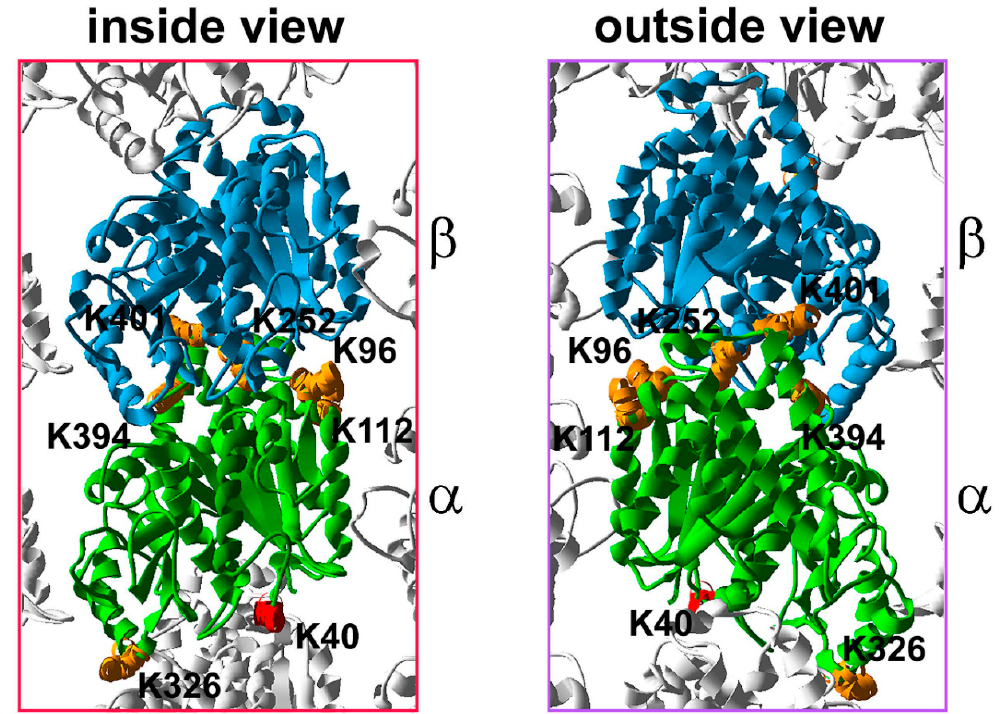
Figure 2. The distribution of the acetylated residues within the α , β -tubulin heterodimer. 3D model of a tubulin heterodimer within the microtubule lattice based on 3J6F.pdb (NCBI database), an inside and outside view. Putative acetylation sites are marked in orange. An approximate location of K40 is marked in red (K40 was not included in the original 3D model). α -Tubulin K96 is located within the S3 strand and builds the plus end surface, responsible for the interactions with β -tubulin of the same heterodimer. α -Tubulin K112 is located in close vicinity to the H3 surface while K326 is located within the H10 helix, and builds the minus end surface responsible for longitudinal interactions between heterodimers within the same protofilament or with γ -tubulin at the nucleation site. α -Tubulin K394 and K401 are located within the H11 helix and H11–H12 loop, respectively which are exposed on the outside surface involved in the interactions with non-tubulin partners of tubulin. K252 of β -tubulin is located within the H8 helix and builds the minus end surface.